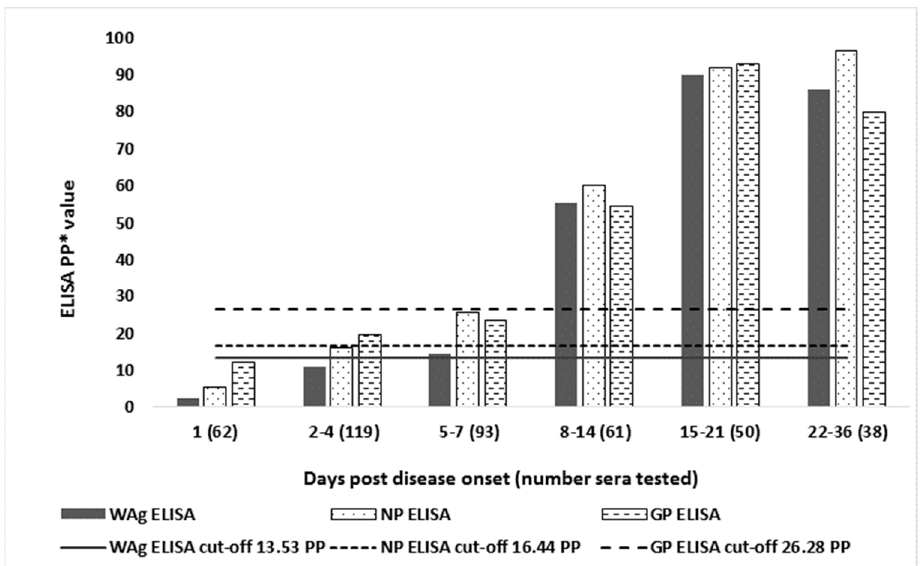
Figure 3. Mean IgG responses in 423 Ebola disease patients measured by a whole antigen (WAg), nucleocapsid (NP), and glycoprotein (GP) indirect ELISAs at different time post disease onset.